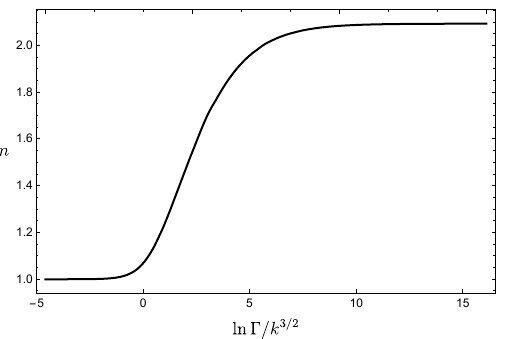
Figure 2 . Plot of the refractive index n , de(cid:12)ned in (3.3), as a function of the dimensionless deformation parameter (cid:0) =k 3 = 2 , for boomerang RG (cid:13)ows with m 2 = (cid:0) 15 = 4 and (cid:24) = 675 =